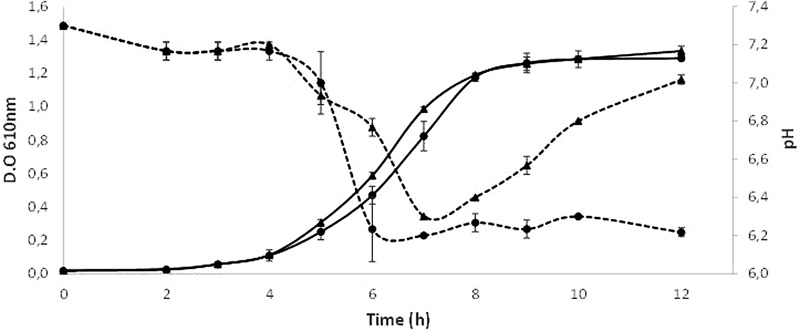
Growth curves of S. dentisani strain 7746 in a medium with (triangles) and without (circles) the addition of 5 g/l of arginine. The mean ± SD of O.D. 610 (solid lines) and pH of the culture (dotted lines) from three replicates are depicted.